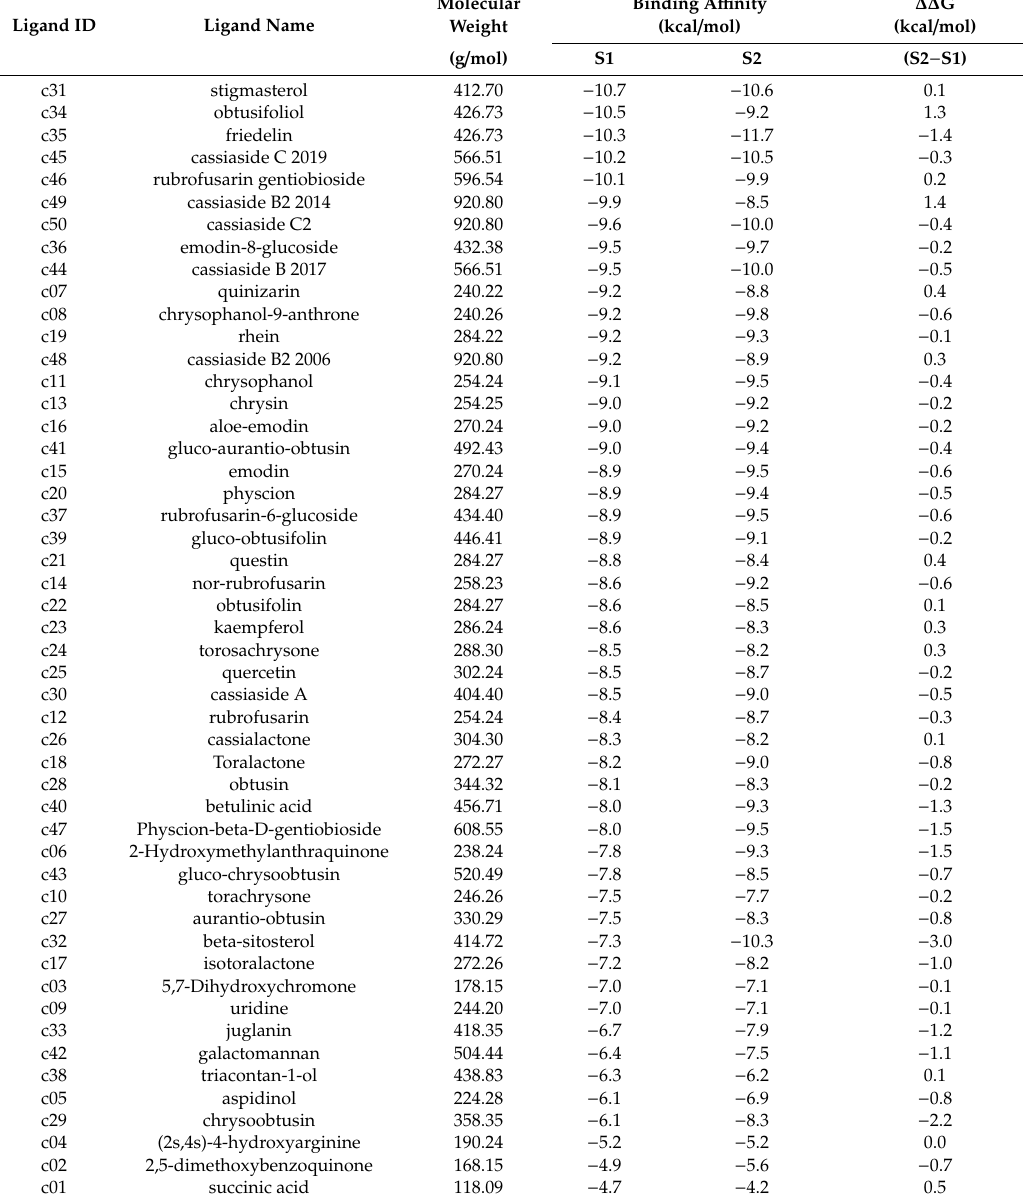
Table A1. Binding a ffi nity and di ff erence in ∆∆ G values between the predicted binding a ffi nity of each Cassiae semen ligand to S1 and S2, sorted according to absolute binding a ffi nity for